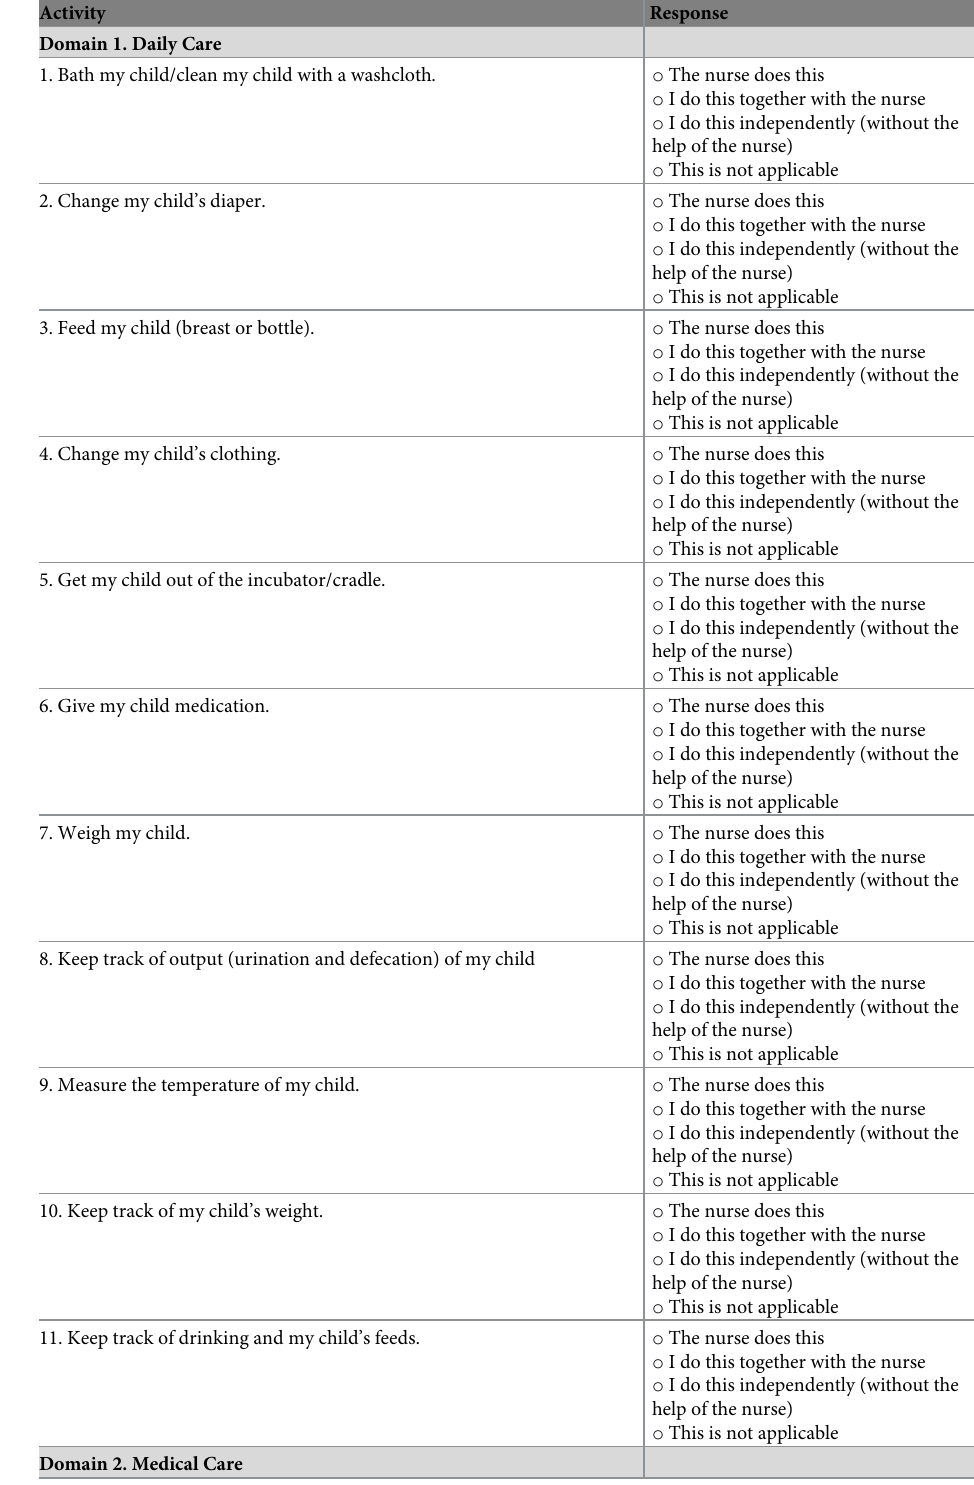
Table 1. CO-PARTNER